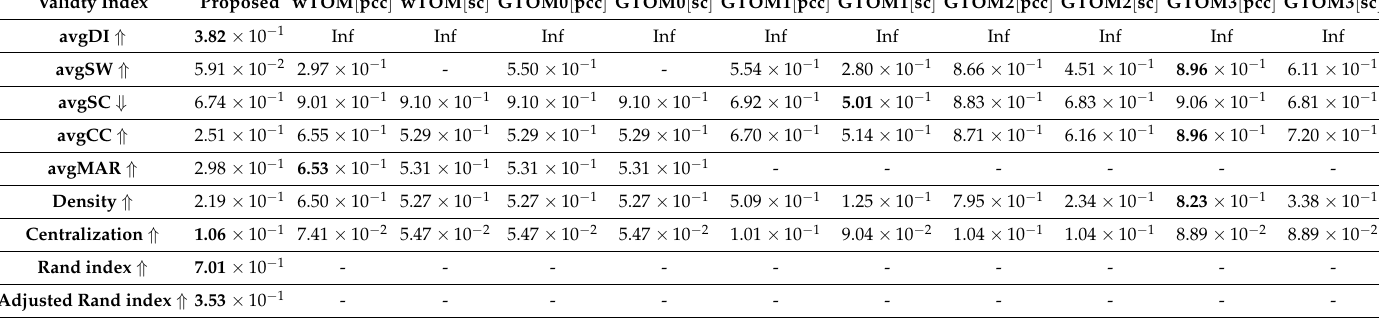
Table 5. Comparison of proposed rule-based gene-module detection method and other existing geneset-based gene-module detection methods in a simulation study for the LUSC